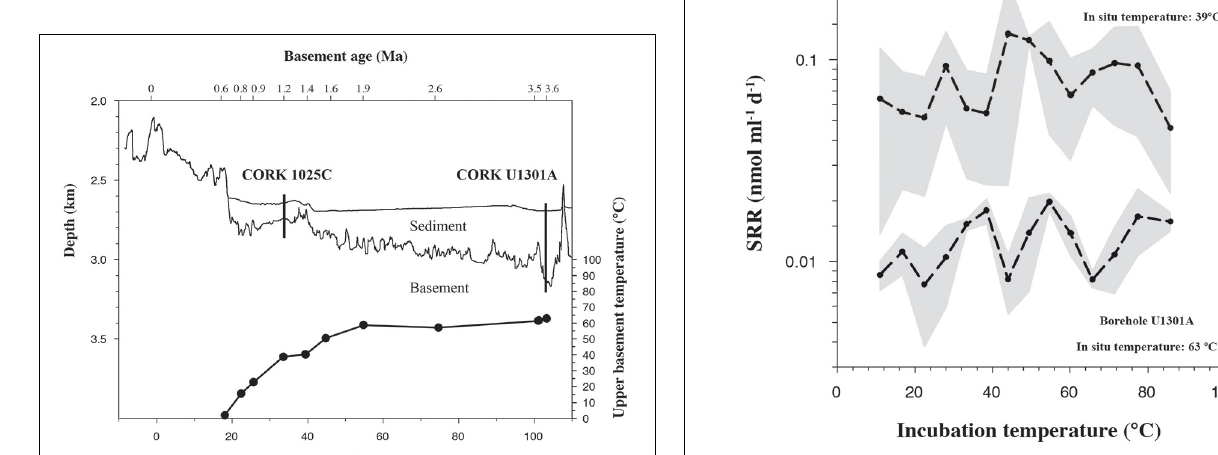
FIGURE 1 | Interpreted composite cross section of the JFR from active spreading center to the west showing sediment thickness, basement topography and age, and temperature. Data from selected results from ODP leg 168 and related experiments (Fisher et al., 2000). Locations of CORKs 1025C and U1301A are indicated.